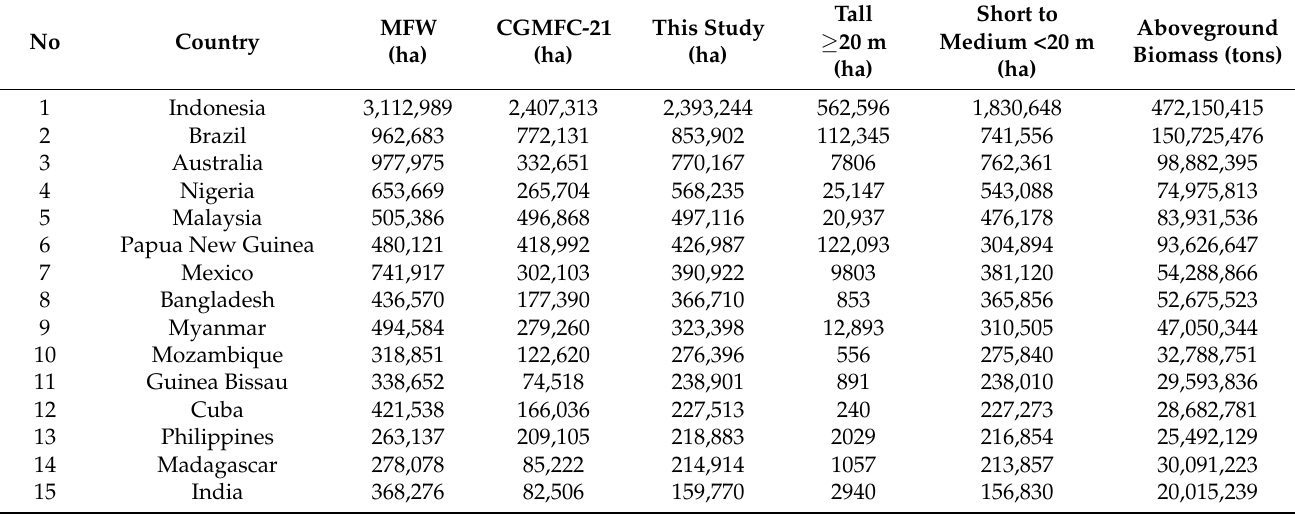
Table 2. Mangrove area and biomass of the 15 most mangrove-rich countries in the world. A comparison of MFW, CGMFC-21, and our results are shown. The areas (ha) of tall ( ≥ 20 m) and short-to-medium (<20 m) mangroves and total mangrove biomass (tons) are also